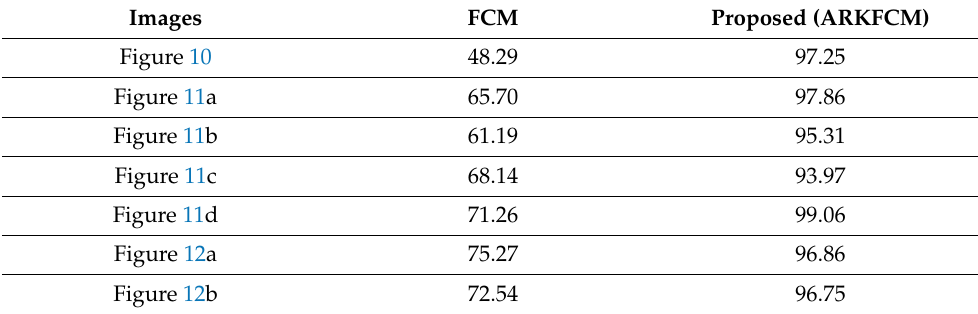
Table 6. Jaccard index with FCM and Proposed ARKFCM method.